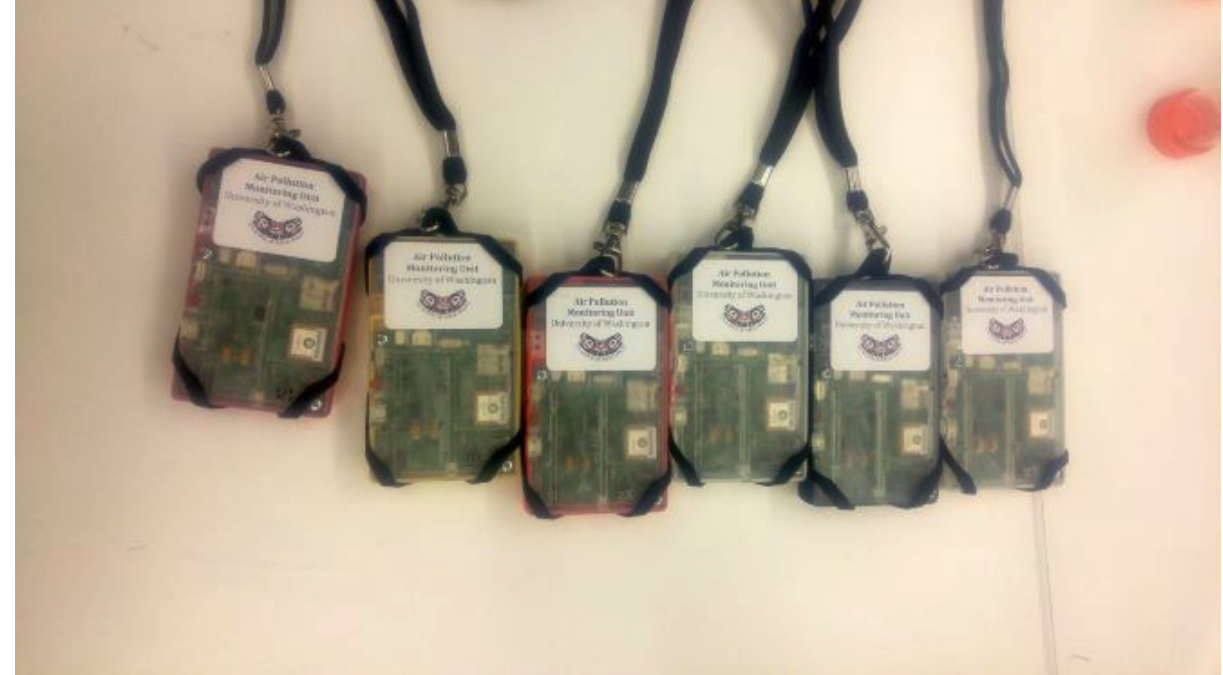
Figure 2. Lanyards were used in cycle 3 to allow participants to carry the air pollution monitor around the neck or attached to a